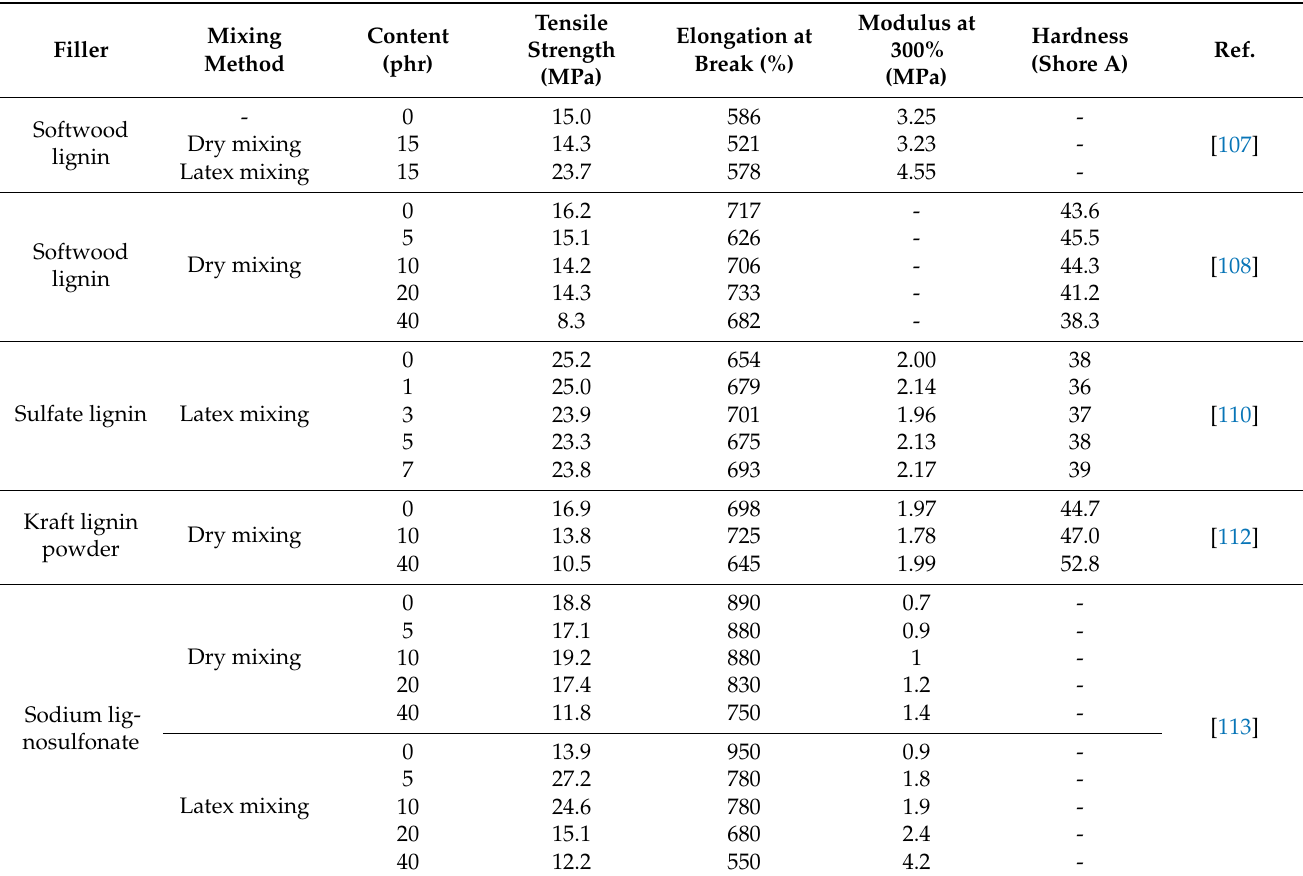
Table 4. Mechanical properties of NR nanocomposites filled with